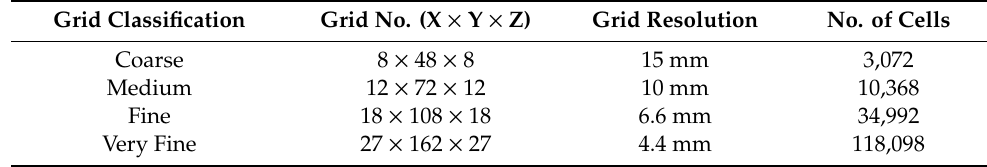
Figure 2. Geometry and initial condition of the problem. Table 1. Different grid size and the number of cells.